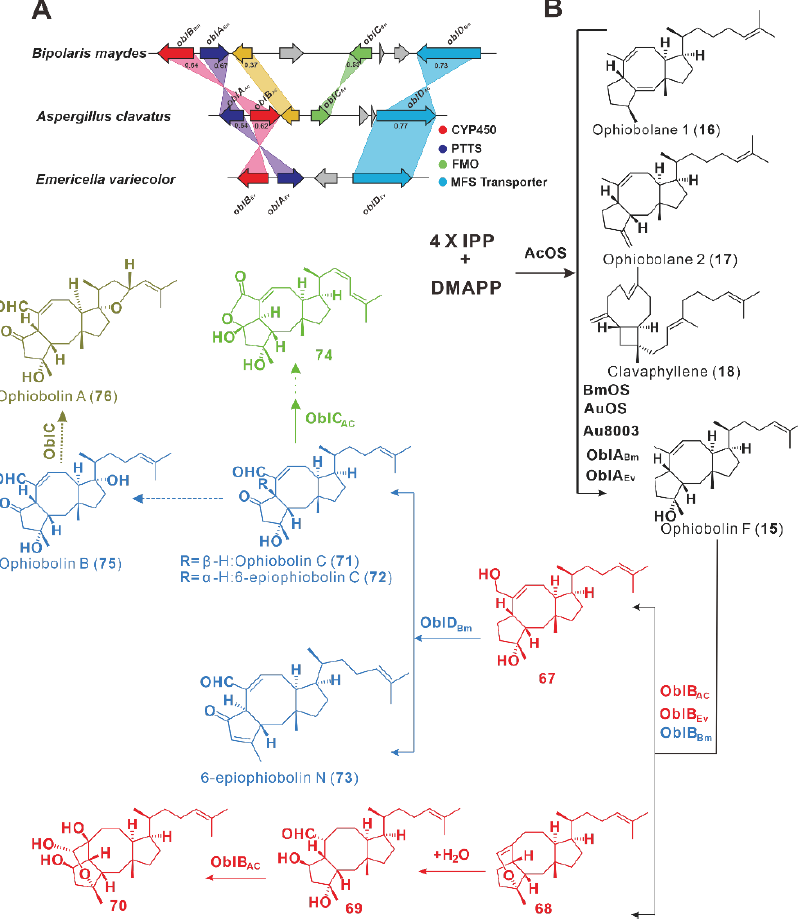
Figure 7. The obl BGCs containing multiple genes ( A ) and their biosynthesis ( B